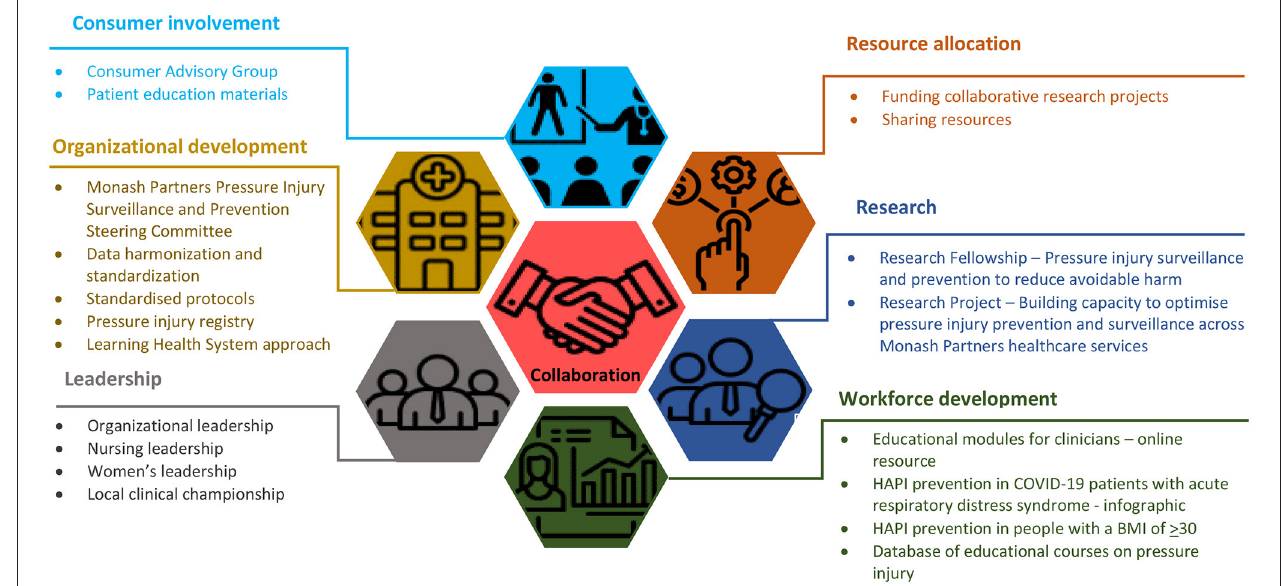
FIGURE 1 | Pressure injury surveillance and prevention. Monash Partners Capacity Building